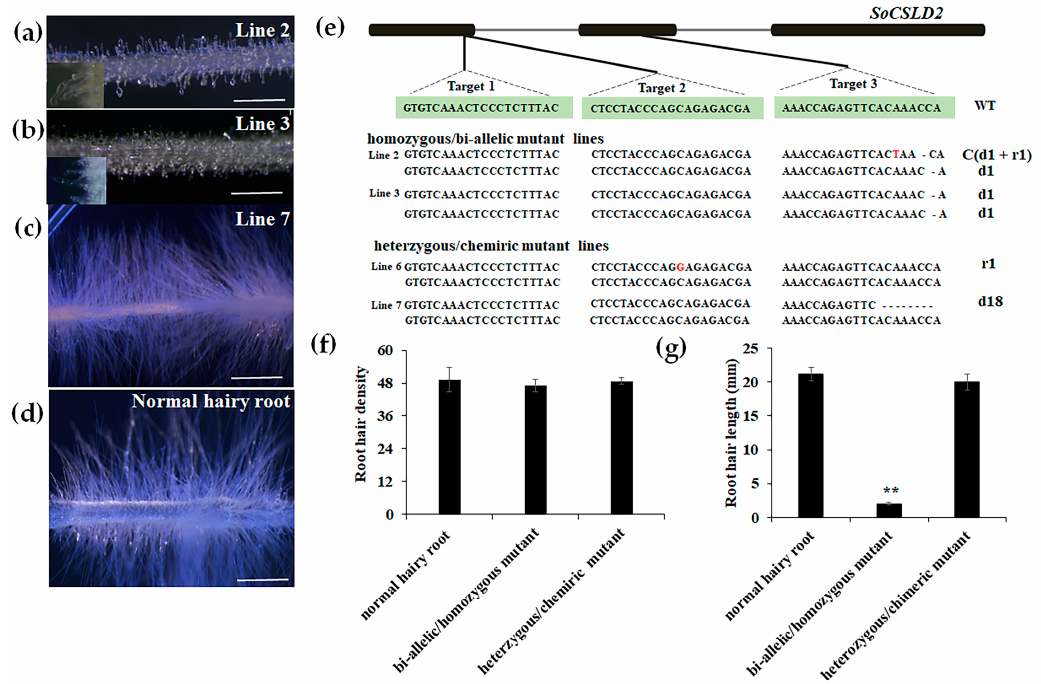
Figure 3. Phenotyping and genotyping of edited hairy root lines of SoCSLD2 . ( a , b ) The phenotypes of bi-allelic line 2 ( a ) and homozygous line 3 ( b ) of SoCSLD2 . Bar = 4 µm. ( c ) The phenotype of the heterozygous mutant line 7 of SoCSLD2 . Bar = 20 µm. ( d ) The phenotype of the normal hairy root. Bar = 20 µm. ( e ) The mutation types of line 2, line 3, line 6, and line 7. The mutation types of each target were labeled in right of the target sites, respectively. Deletion bases were indicated by dashed lines; d#, number of bases deleted from the target site. Replacement bases were showed in red; r#, number of bases replaced at the target site; c, combined mutations (more than one mutation type in one allele). ( f ) Root-hair density and ( g ) root-hair length analysis of normal hairy roots, bi-allelic/homozygous mutant and heterozygous/chimeric mutant lines of hairy roots. Root-hair length and density were measured at the region 1.5 to 2 mm from the root tip. Root-hair density is shown as root hair number per mm 2 ; 24 roots of three lines (8 roots for each line) were measured for each mutation type, and the values were mean ± SD. Asterisk (**) indicates that difference is significant at p < 0.01.